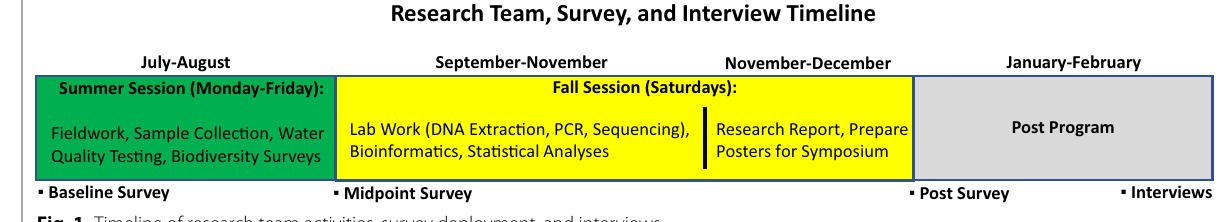
Fig. 1 Timeline of research team activities, survey deployment, and